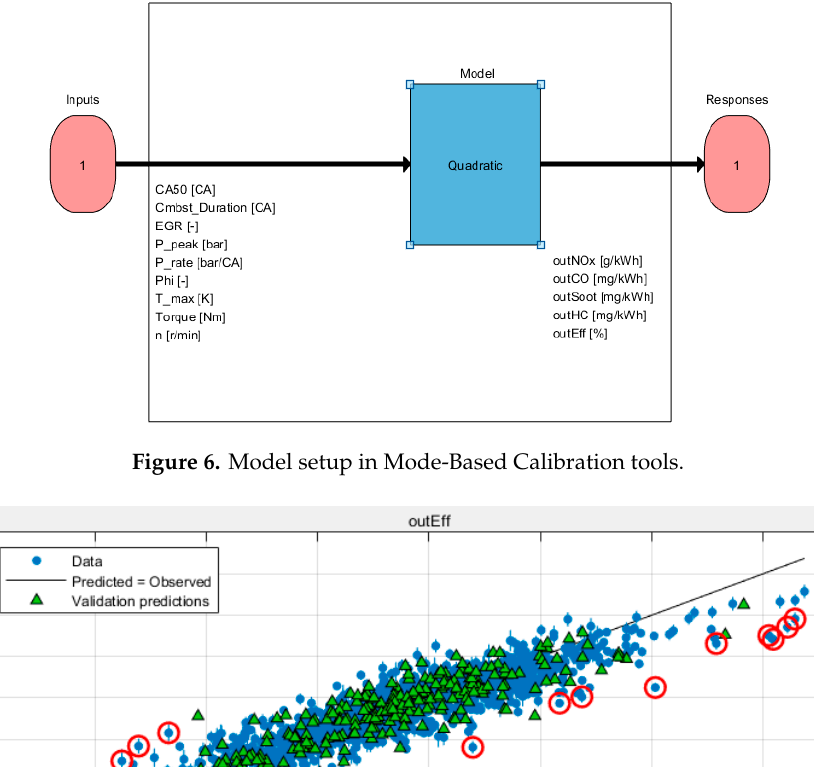
Figure 6. Model setup in Mode-Based Calibration tools.